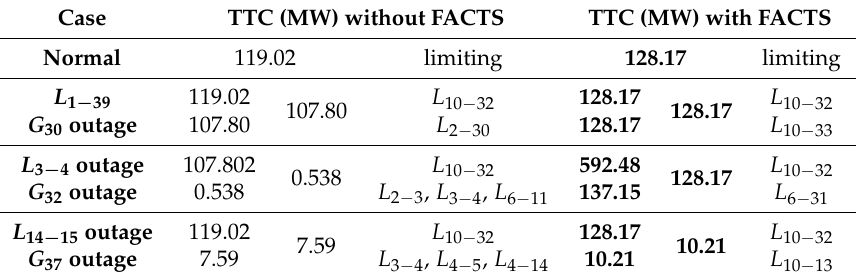
Table 9. TTC values from area1 to area 2 for IEEE 39 bus